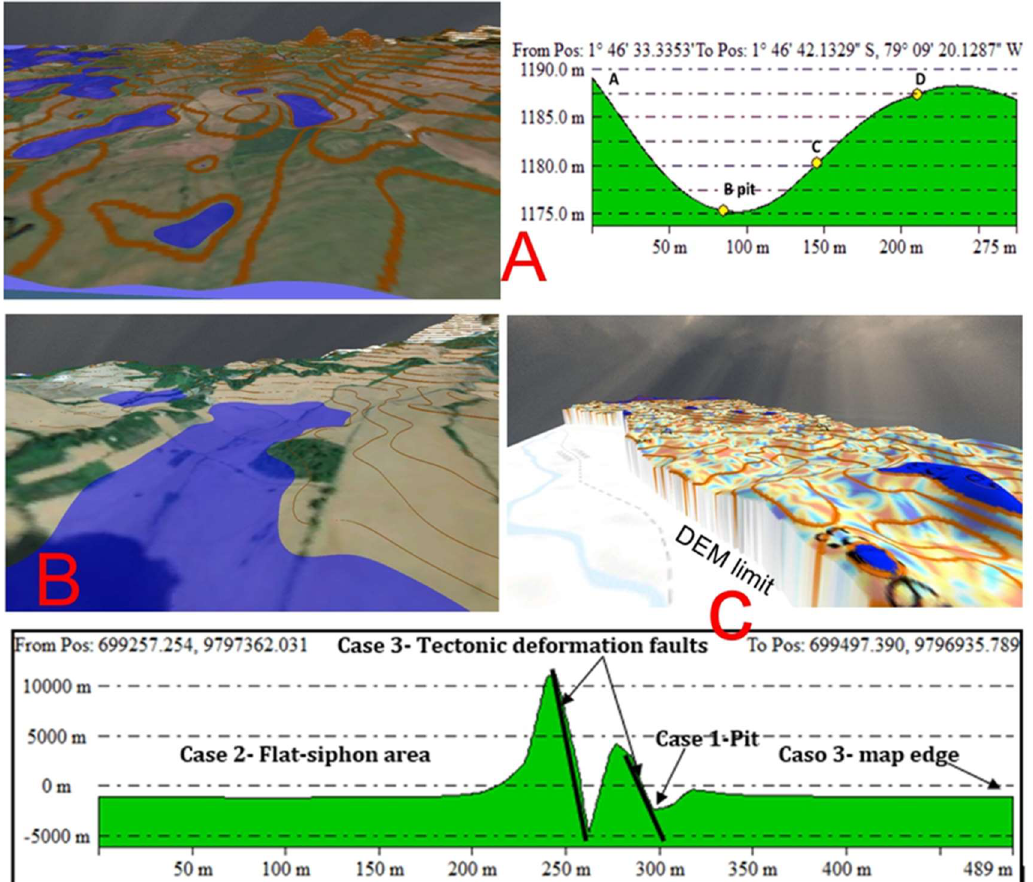
Figure 4. ( A ) Case 1, pit: cell C1 is surrounded by 8 cells higher than it. ( B ) Case 2: Cell C1 is part of a group of cells with the same dimension, which represent flat areas. If the flat area is surrounded by higher cells, it is as a sink. ( C ) Case 3, Indeterminacy: more than one cell is adjacent to C1 with slope equal to the maximum. This problem is called an indeterminacy and occurs when C1 is not on a coastal edge or DEM boundary.